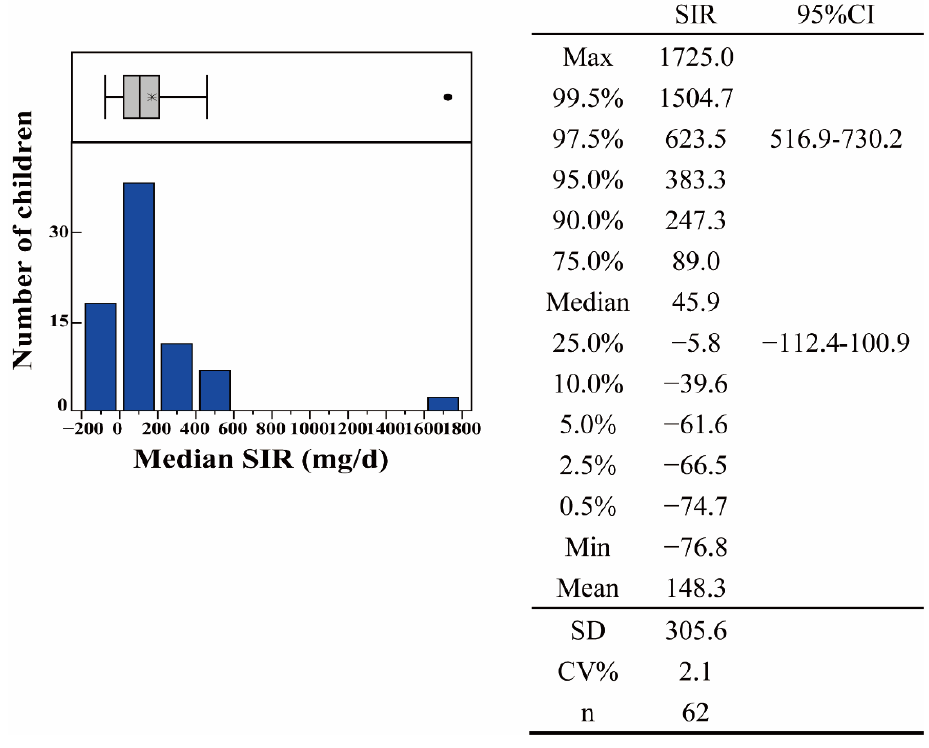
Figure 3. Frequency distribution histogram based on the BTM. All basic statistical parameters of SIR results are listed by the side of histogram. The * represents mean values, and dot sign represents outliers.